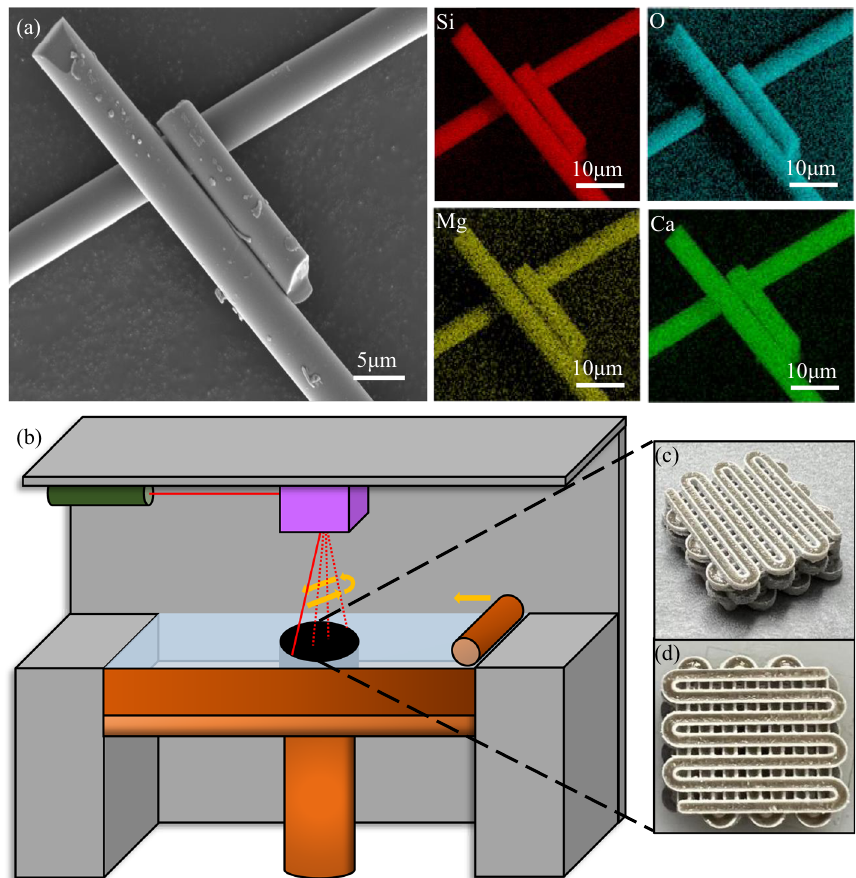
Fig. 1 Preparation and fabrication process of the scaffolds. ( a ) EDS images of BCF, ( b ) SLS process for fabricating composite scaffold, ( c , d ) images of the fabricated composite